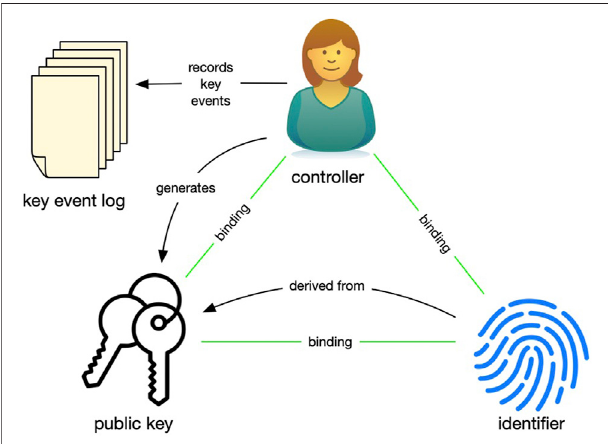
FIGURE 4 | Trust basis in autonomic identity